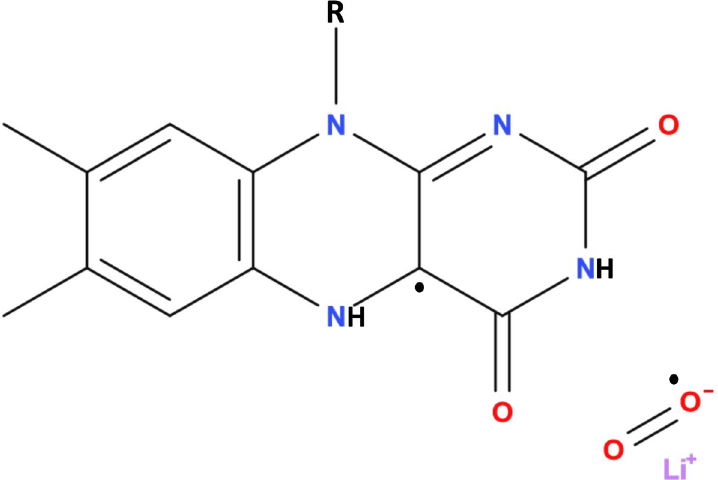
. ] and lithium superoxide [Li + -O2